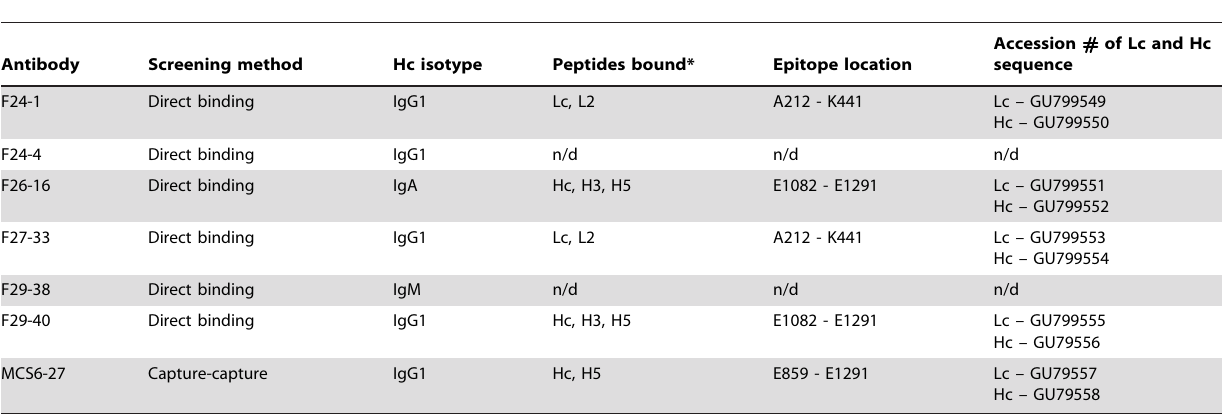
Table 2. Characterization of monoclonal antibodies to